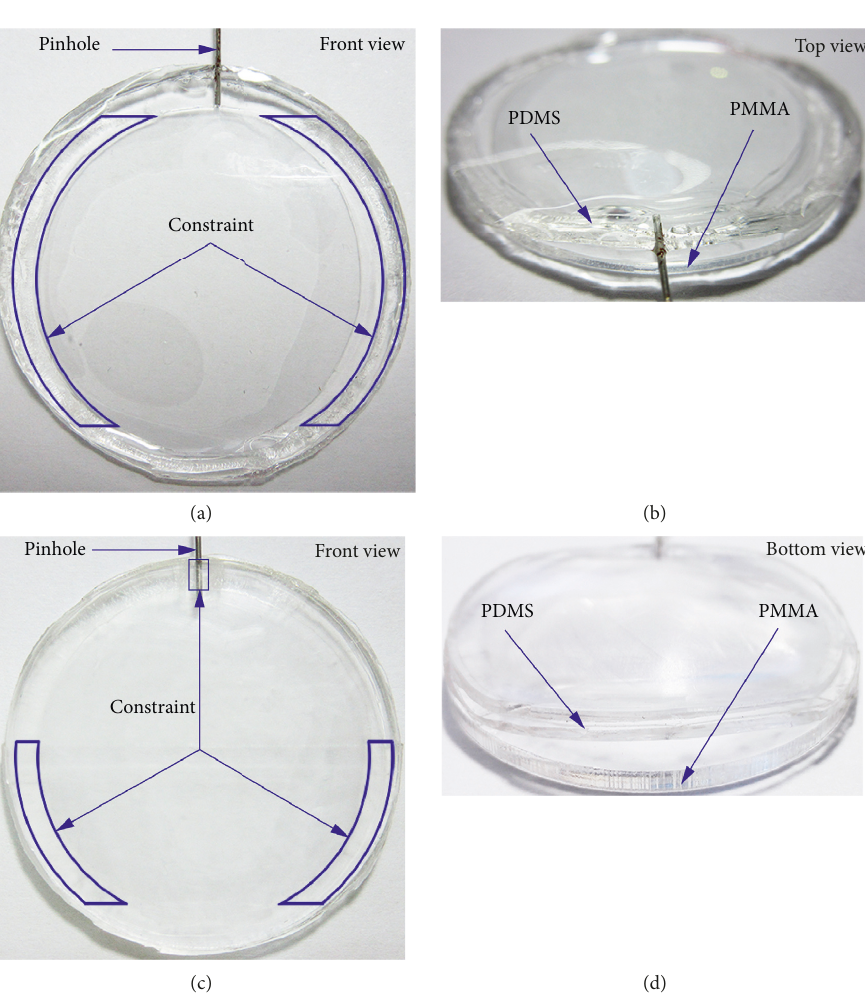
Figure 11: Liquid lens with constraint of two parts of edges clamped. (a) Front view. (b) Top view. Liquid lens with constraint of three parts of edges clamped. (c) Front view. (d) Bottom